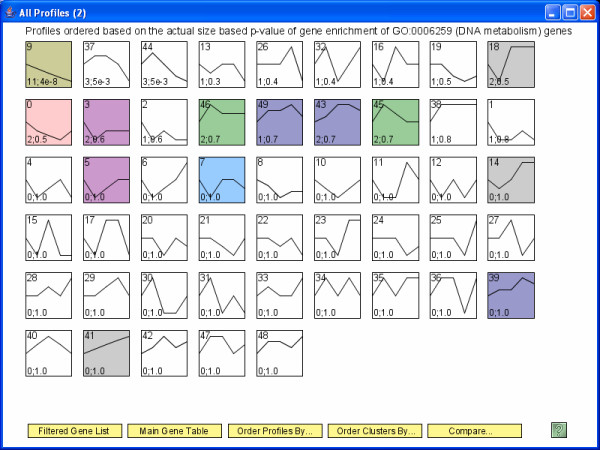
Model profiles reordered interface. The profiles from Figure 3 are reordered based on actual size based p-value enrichment for genes being annotated as belonging to the GO category DNA metabolism. For each profile the number of DNA metabolism genes assigned to it and the enrichment p-value appears in the lower left corner of the profile box.